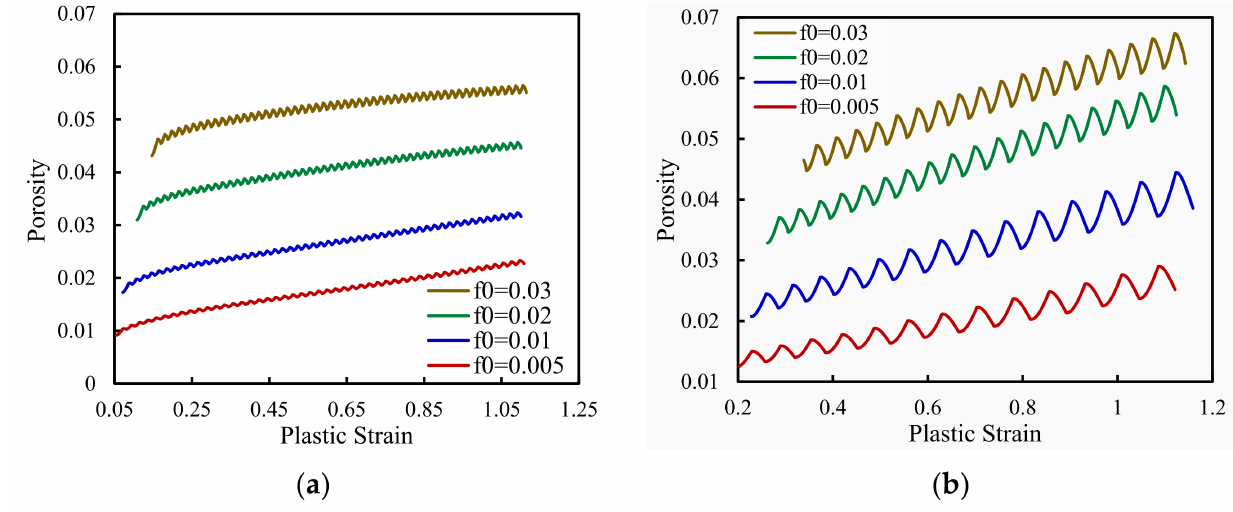
Figure 5. Porosity growth due to the accumulation of plastic strain for distinct values of f 0 for: ( a ) a 0 = 11.5 mm and ( b ) a 0 = 19 mm. Results are shown in natural